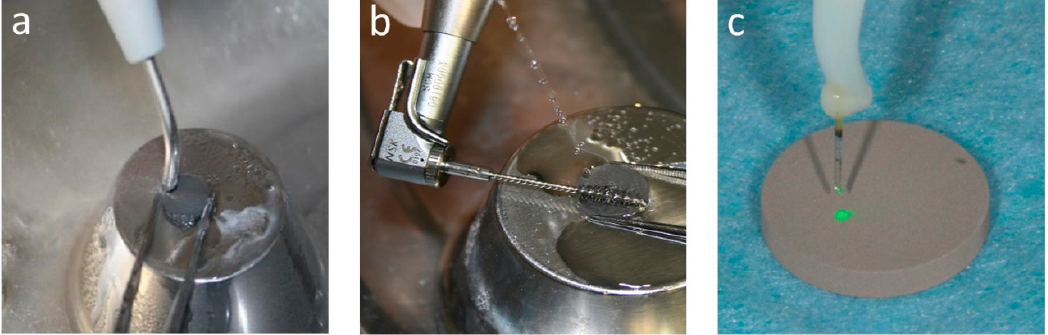
Figure 1. ( a ) Air powder abrasion with glycine powder; ( b ) titanium brush; ( c) diode